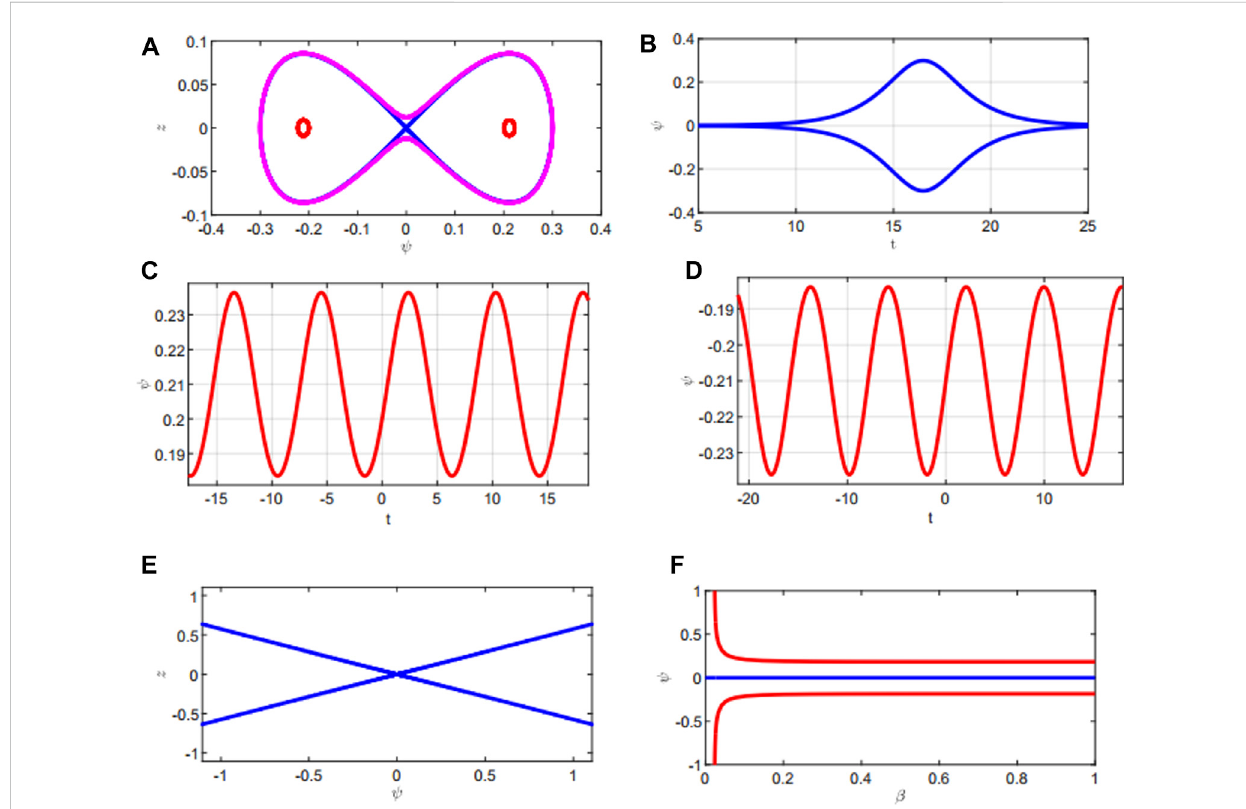
FIGURE 9 (A) Phase plane diagram in the ( ψ , z ) plane for β =0.1 and A > 0. (B) Solitary wave. (C) – (D) Periodic wave for β =0.1 and A > 0. (E) Phase plane diagram in the ( ψ , z ) plane for β =0.01 and A < 0. (F) Bifurcation diagram between β and ψ keeping other parameters as α =0.3, δ =0.01, γ =0.7, ] =0.9, and μ =0.1.